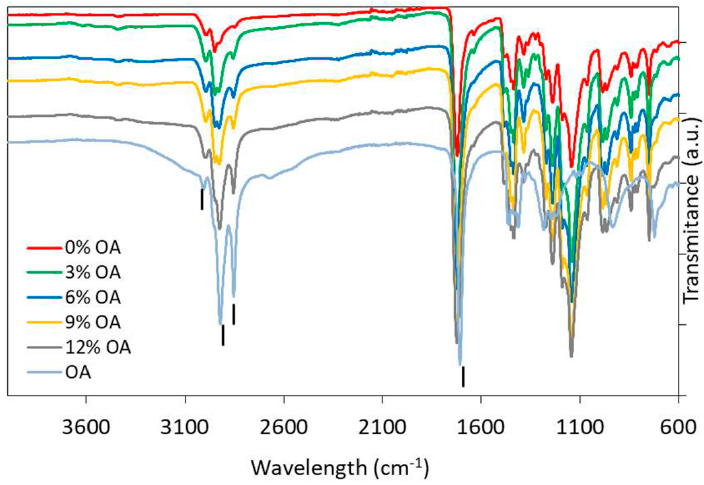
Figure 1. Fourier − transform infrared spectra of pure oleic acid, Poly(methyl methacrylate) and composites with 3%, 6%, 9%, and 12% ( w / w ) OA.